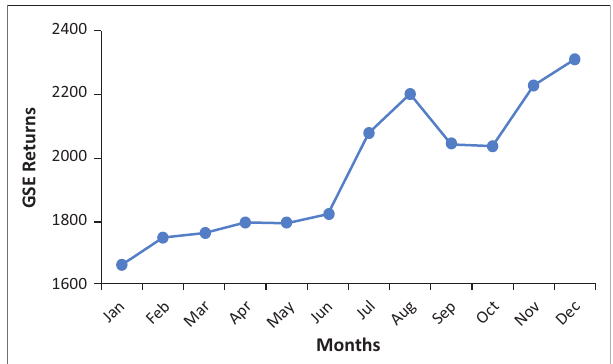
FIGURE 2: Ghana Stock Exchange performance in